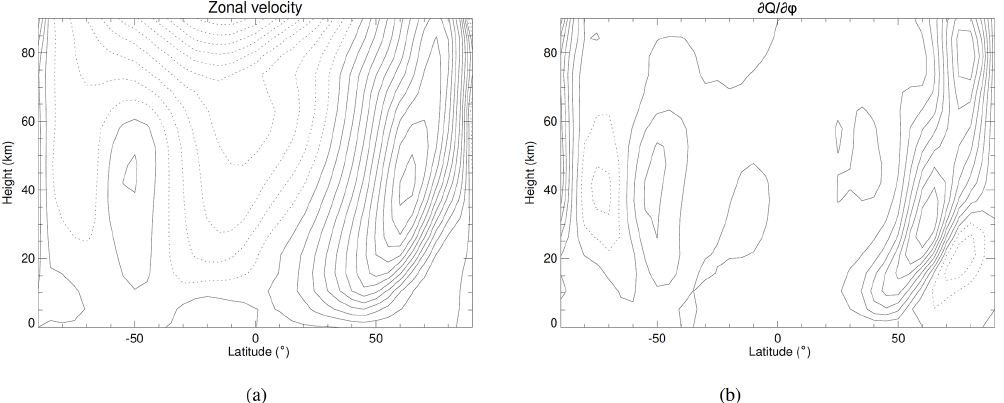
Figure 13. Zonal-mean sections of (a) zonal wind (ms − 1 ) and (b) ∂Q/∂φ (s − 1 rad − 1 ) typical of winter in the Martian northern hemisphere. Data were taken from the Mars Climate Database (e.g. Lewis et al., 1999); see also http://www-mars.lmd.jussieu.fr/mars/access.html, last access: 30 March 2020 for L s = 270 ◦ using the standard Mars climatology. Contour intervals are (a) 15ms − 1 and (b) 0.0002s − 1 rad − 1 , and negative contours are shown